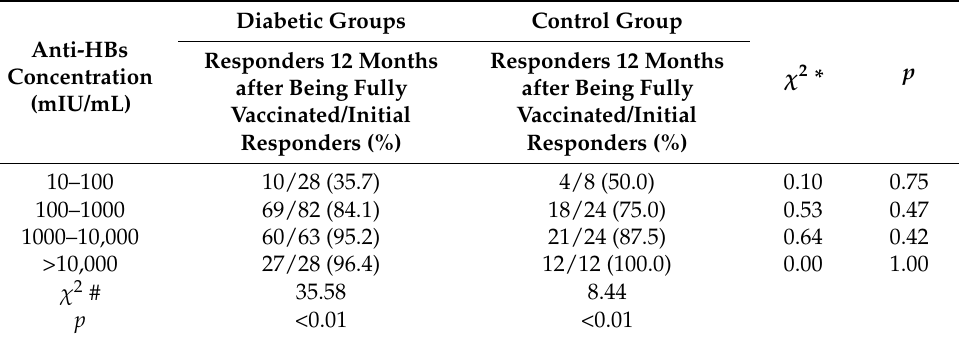
Table 2. The ability of different anti-HBs concentrations to maintain positive twelve months after being fully